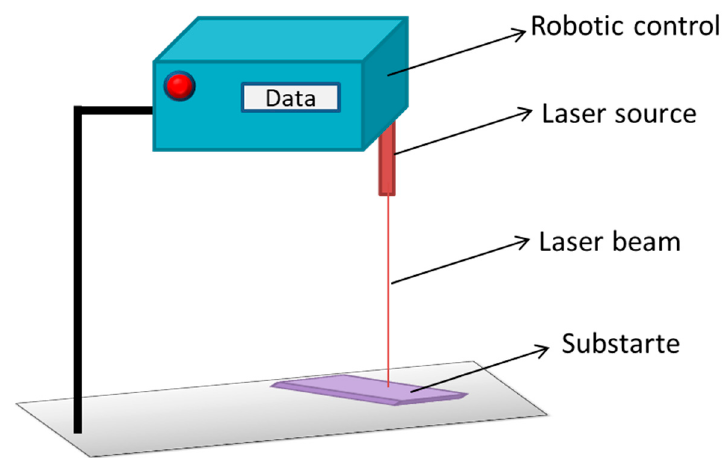
Figure 20. Diagrammatic representation of laser source used to harden the surface of the substrate. The action of laser source is controlled by robot or machine learning.